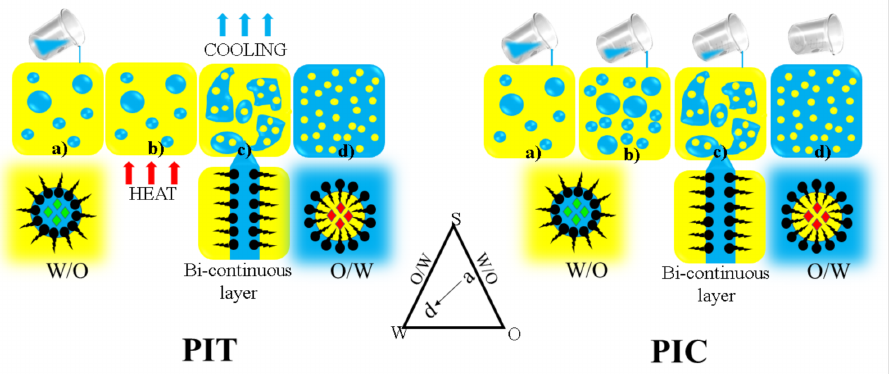
Figure 3. Illustration of phase inversion emulsification with varying temperatures (PIT) and varying compositions (PIC). The emulsion undergoes steps a-d to finally form a O/W emulsion. This is a self-drawn